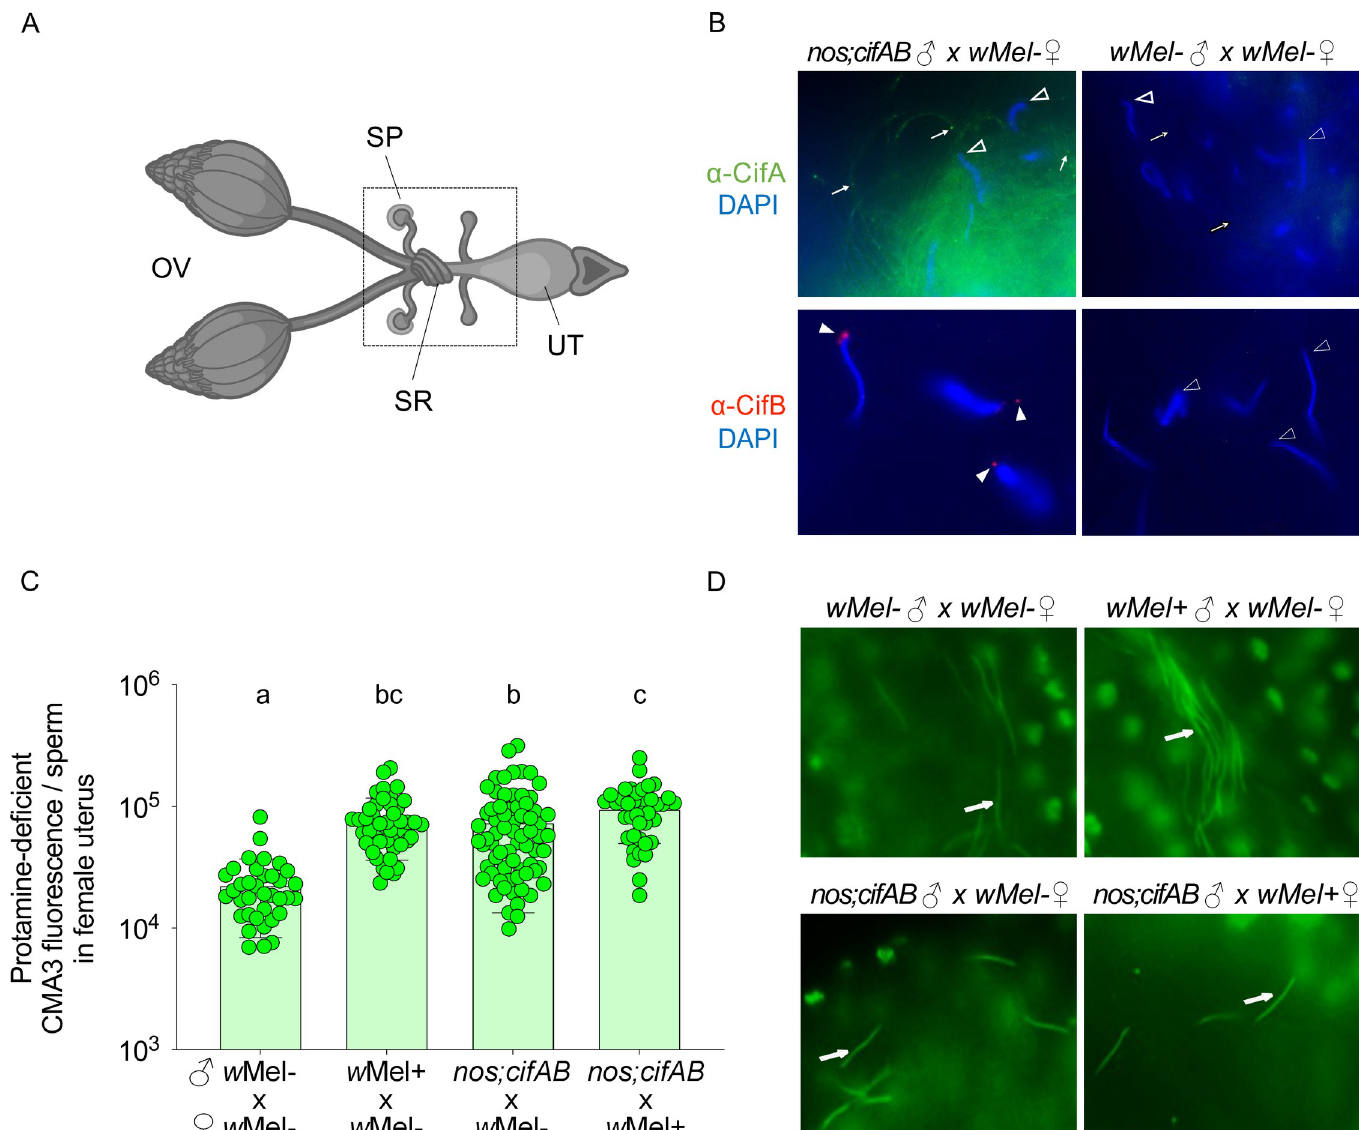
Fig 5. CifA, CifB, and the protamine deficiency are transferred with the mature sperm to the female reproductive tract. (A) Schematic representation of Drosophila melanogaster female reproductive system. Mature oocytes leave the OV and reach the UT, where they can be fertilized prior to being laid. Sperms from males are stored in specialized organs—SP and SR shown in the box, which open into the UT for fertilization to occur. Schematic is created with BioRender.com. (B) Transgenic cifAB - expressing and w Mel − males were crossed to w Mel − females. Four hours postfertilization, sperms isolated from females were decondensed and immunostained for localizing CifA (green) and CifB (red). DAPI stain (blue) was used to label nuclei. CifA is absent in sperm heads (empty arrowheads) and puctae are seen along the sperm tails (arrows). CifB is present in apical acrosomal tip of all of the sperm heads (solid arrowheads), with more distant signal in the more decondensed sperm nuclei. No Cifs are present in the sperms transferred from w Mel − negative control males. (C) Individual sperm intensity quantification shows that protamine deficiency of sperms from w Mel+ and transgenic cifAB males persists after transfer in the females compared to w Mel − males. Sperm protamine deficiency from transgenic cifAB males also persists in the reproductive tract of w Mel+ females. Vertical bars represent mean, and error bars represent standard deviation. Letters indicate statistically significant ( p < 0.05) differences as determined by multiple comparisons based on a Kruskal–Wallis test and Dunn multiple test correction. All of the p -values are reported in S1 Table, and raw data underlying this panel can be found in S1 Data file. (D) Representative images of CMA3-stained mature sperms (arrows) transferred from w Mel − , w Mel+ and transgenic cifAB males in w Mel − and w Mel+ female reproductive systems are shown. CMA3, chromomycin A3; OV, ovary; SP, spermathecae; SR, seminal receptacle; UT,